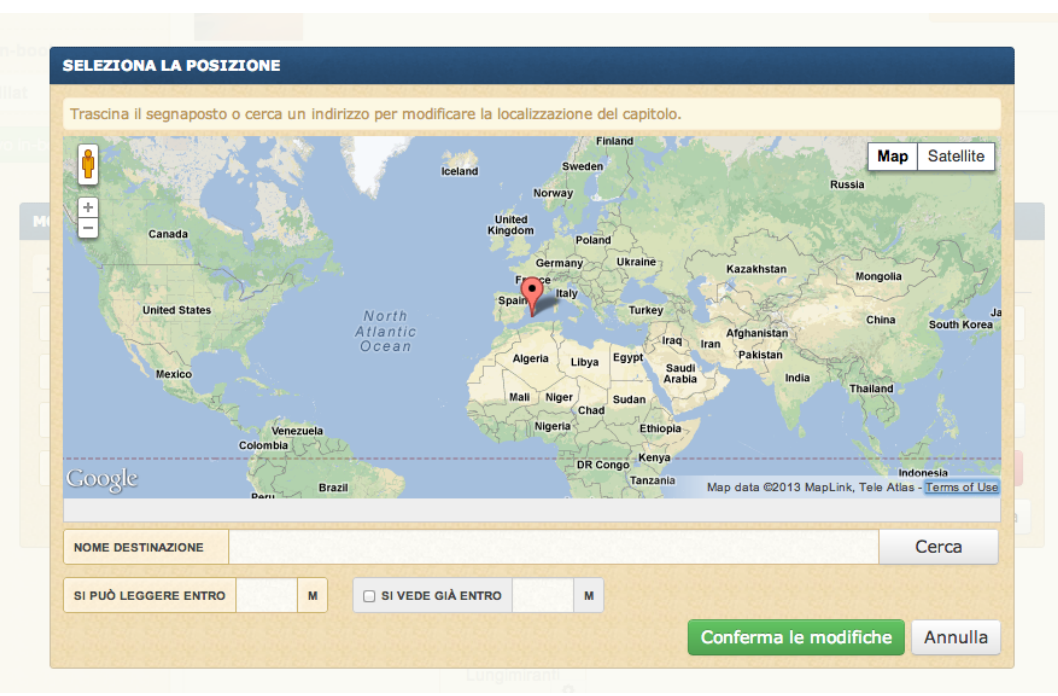
Figure 7. Inbooki localization